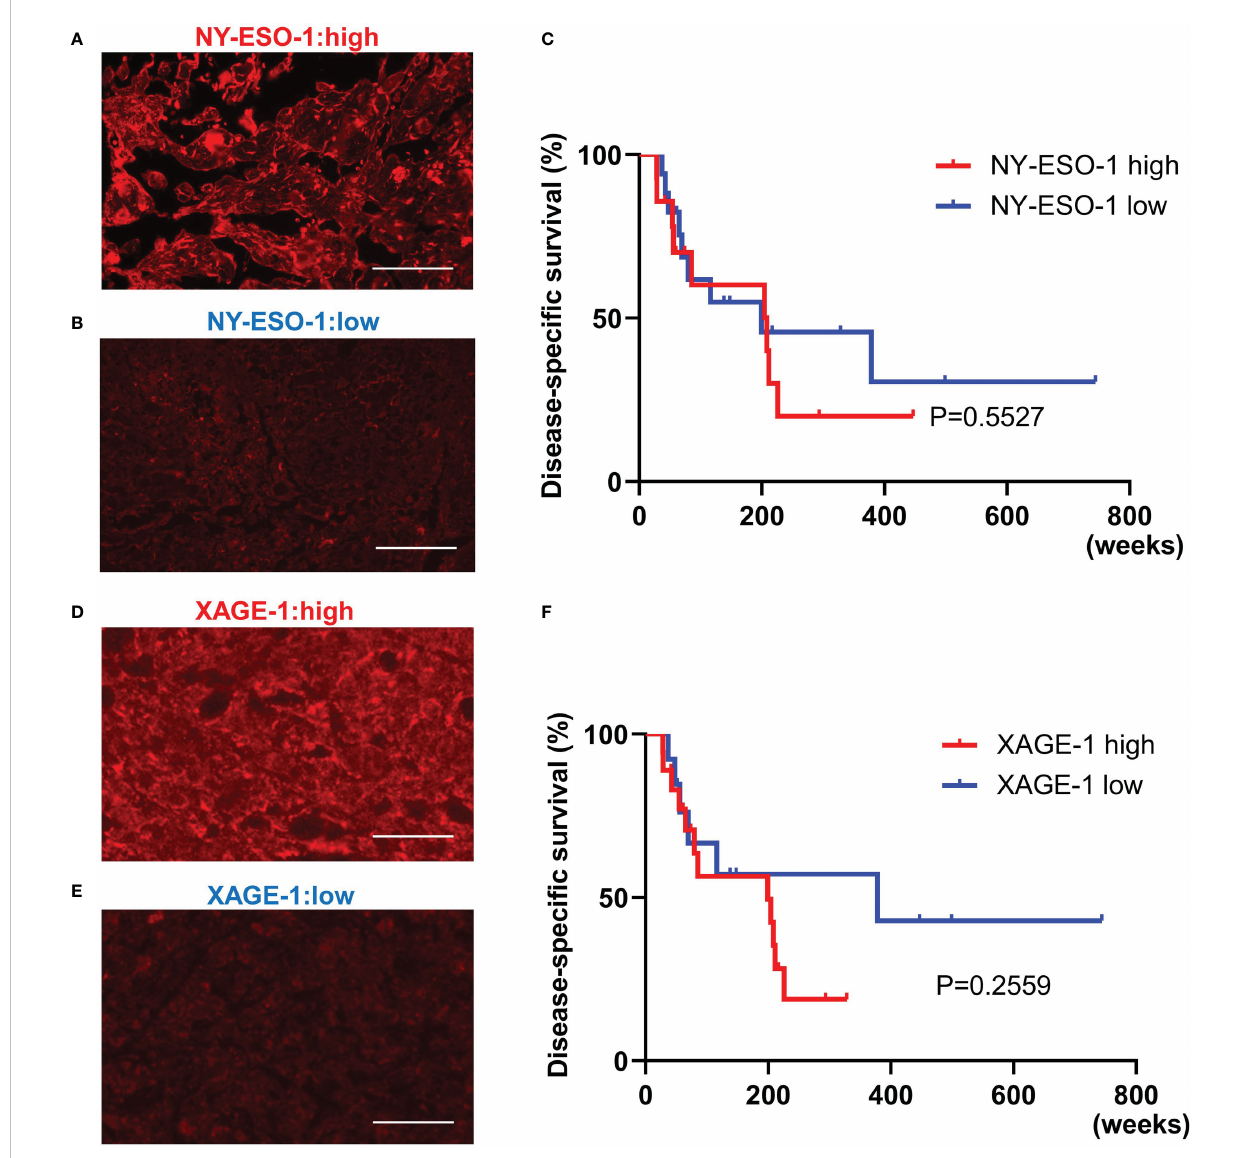
FIGURE 5 The relationship between NY-ESO-1/XAGE-1 expression in primary lesion and prognosis in CAS. Representative immuno fl uorescence staining in samples with high NY-ESO-1 expression. Scale bar, 50µm (A) . Representative immuno fl uorescence staining in samples with low NY-ESO-1 expression. Scale bar, 50µm (B) . Kaplan-Meier survival curves for the patients with high and low NY-ESO-1 expression in primary lesion using log- rank test (n=31, log-rank, p-value=0.5527). NY-ESO-1 high: 14 cases. NY-ESO-1 low: 17 cases (C) . Representative immuno fl uorescence staining in samples with high XAGE-1 expression. Scale bar, 50µm (D) . Representative immuno fl uorescence staining in samples with low XAGE-1 expression. Scale bar, 50µm (E) . Kaplan-Meier survival curves for the patients with high and low XAGE-1 expression in primary lesion using log-rank test (n=31, log-rank, p-value=0.2559). XAGE-1 high: 18 cases, XAGE-1 low: 13 cases (F)